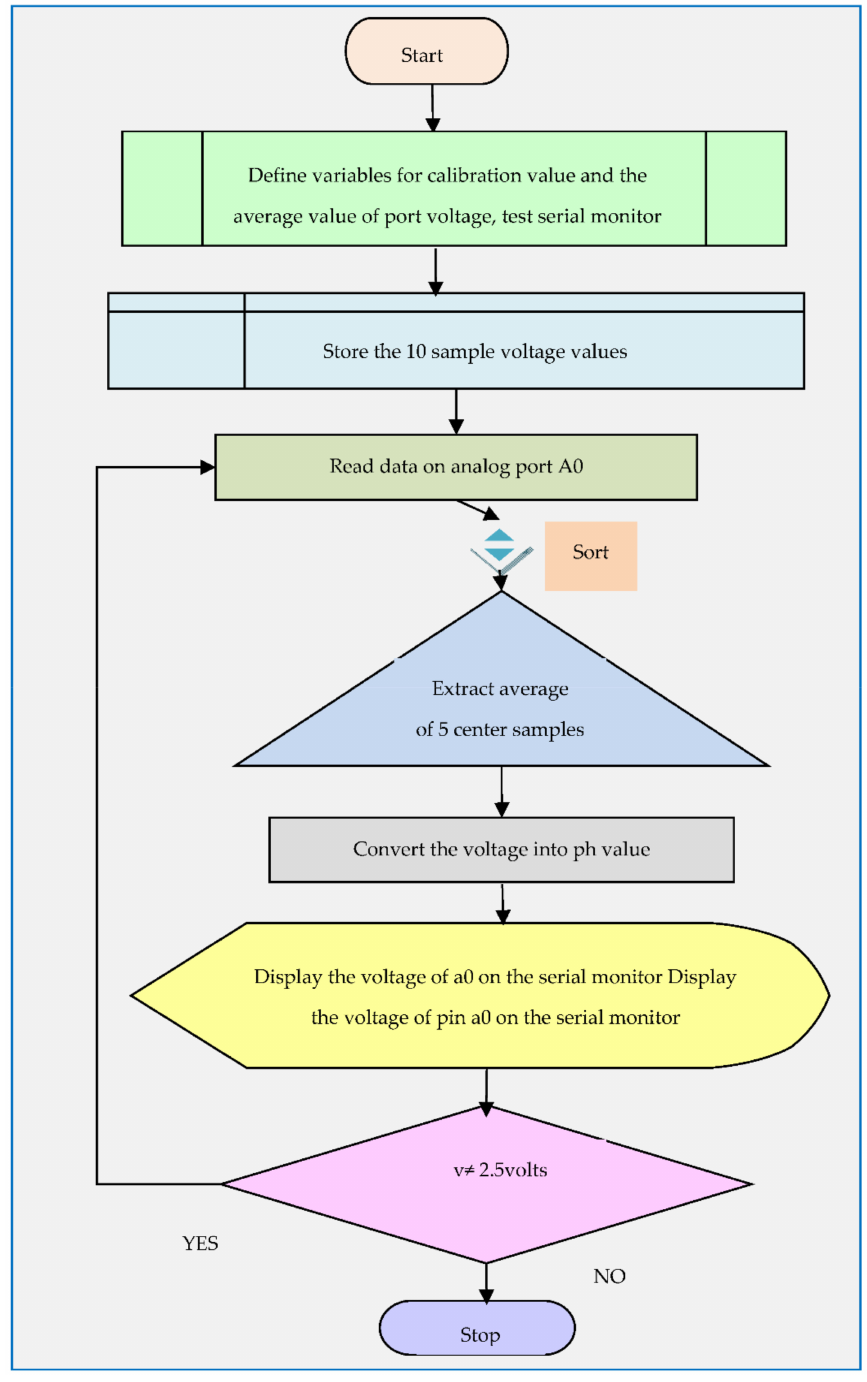
Figure 11. pH sensor measurement